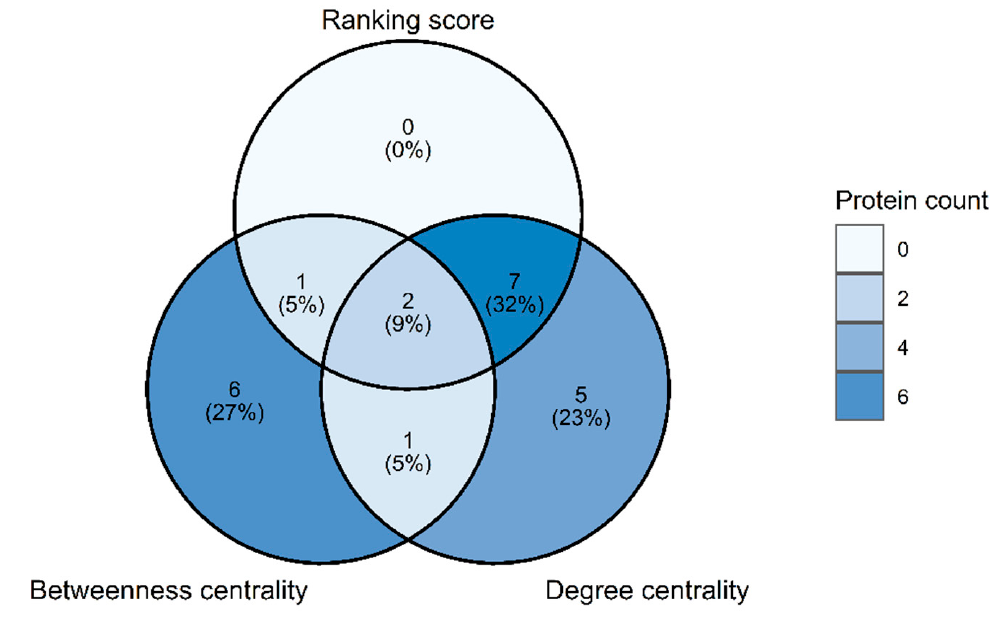
Figure 8. Venn diagram of the key proteins in the ranking score, degree, and betweenness centrality. RSAD2 or viperin is a broad-spectrum antiviral protein in several viruses such as measles, coxsackievirus A16, and enterovirus A71 [142–144]. Moreover, an animal study revealed that RSAD2 was necessary for dendritic cell development [145]. The DEGs analysis of the overlapping genes in postmortem lung tissue from COVID-19 cases